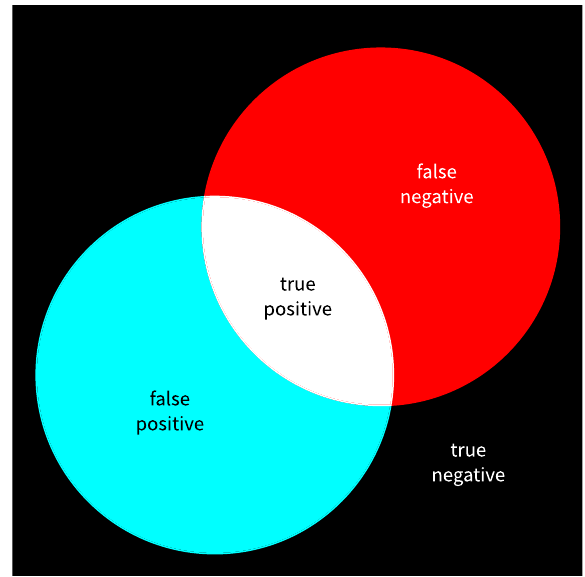
Fig. 1 Illustration of accuracy metrics. The top-right circle is the ground truth, and bottom right is the prediction, then the True Positive is shown in white, True Negative in Black, False Positive in Cyan, and False Negative in Red.